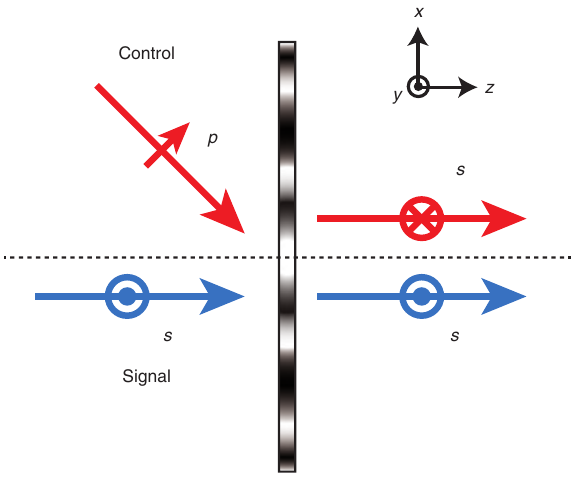
Figure 13: Coherent modulator metasurface. The signal and control beams are impinging on the metasurface at different angles to avoid collocation of their source. The amplitude of the transmitted wave depends on the phase difference between the two beams by interference.